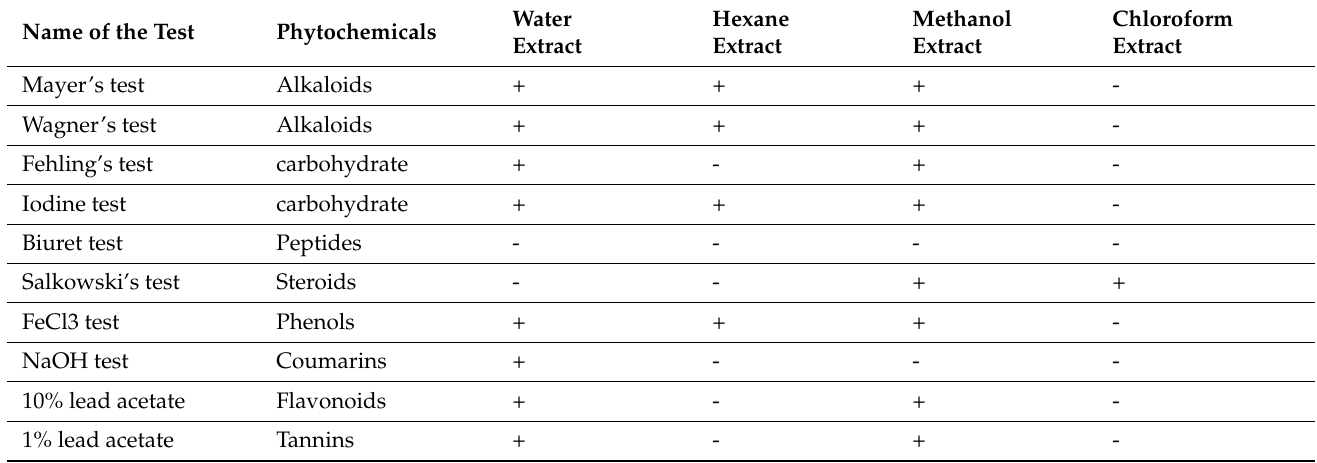
Table 1. Phytochemical content of the Sesbania grandiflora